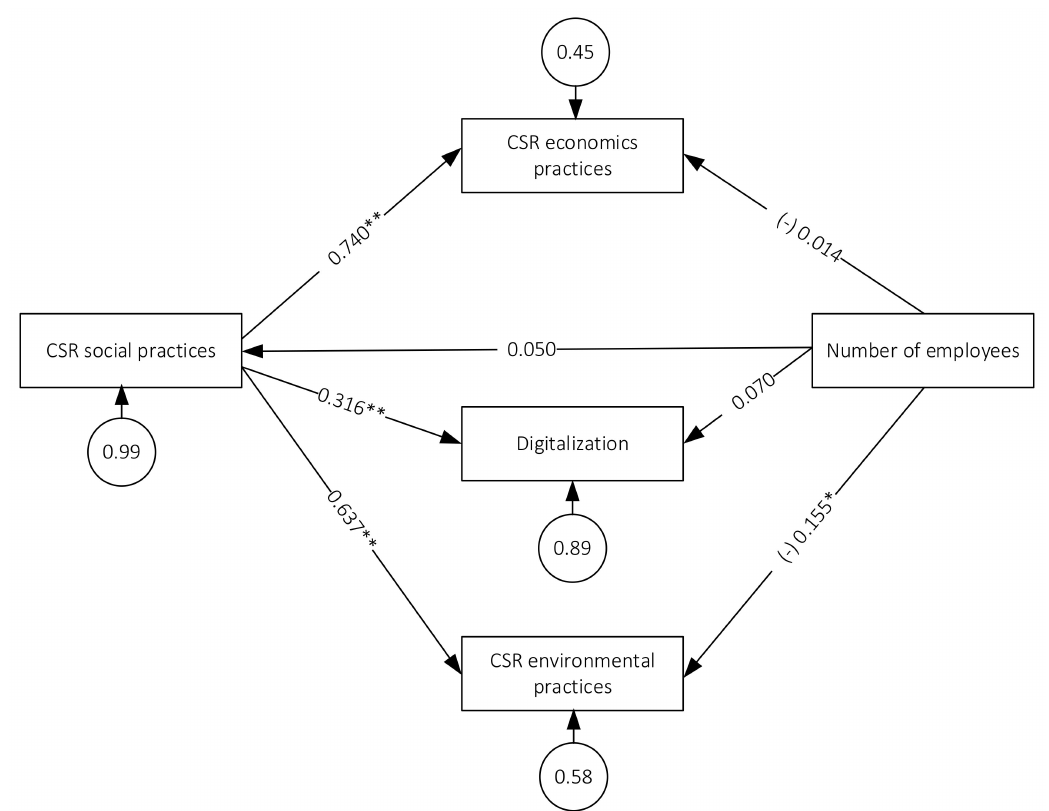
Figure 1. Results of SEM analysis: * p < 0.05, ** p <